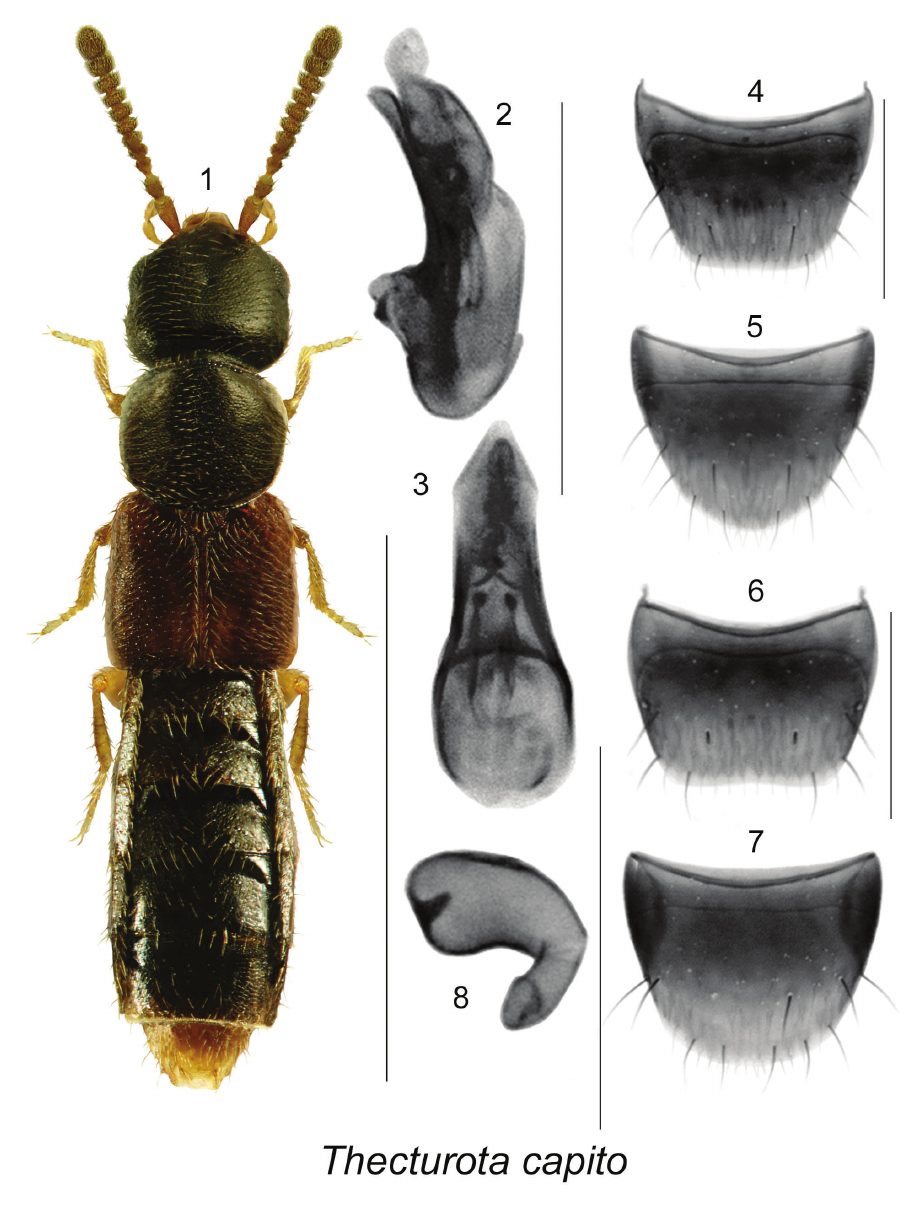
Figures 1–8. Thecturota capito Casey: 1 habitus in dorsal view 2 median lobe of aedeagus in lateral view 3 median lobe of aedeagus in dorsal view 4 male tergite VIII 5 male sternite VIII 6 female tergite VIII 7 female sternite VIII 8 spermatheca. Scale bars: 1 mm for habitus; 0.2 mm for remaining